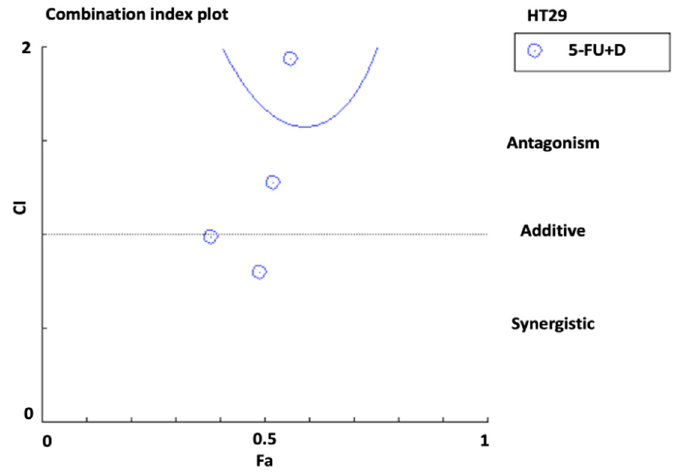
Figure 6. Combination index plot (Fa-CI plot) of interaction between 5-FU and diosmetin (D) in HT29 cells generated by CompuSyn software. Fa: inhibitory effect, CI: combination index. Fa of 0.5 represents 50% growth inhibition.